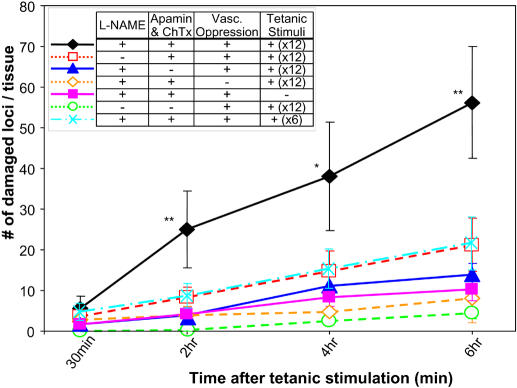
Severe ischemia induced by pharmacological interventions results in myofiber damage in control mouse receiving repeated tetanic stimulation.Numbers of damaged myofiber loci (y-axis) were counted throughout the entire tissue using in vivo microscopy and plotted against time after tetanic contraction (x-axis). For quantification of myofiber damage, the numbers of damaged sites (loci) were counted instead of numbers of the damaged fibers, because there are different types of damage observed along the length of a myofiber (see Methods for detail). When ischemia stress was provided by applying L-NAME, apamin plus charybdotoxin (ChTx), and vascular oppression, control mice showed progressive increase in the amount of muscle damage (closed diamond and black solid line) under the application of increased stimuli (12 times). However, when L-NAME (open square and red dotted line), apamin plus charybdotoxin (closed triangle and blue solid line), or vascular oppression (open diamond and orange dotted line) was lacking, a comparable amount of myofiber injury was not achieved. Even when all reagents were present, the amount of myofiber damage was minimal without tetanic contraction (closed square and pink solid line). Tetanic stimulation and vascular oppression alone did not cause significant myofiber destruction (open circle and green dotted line). Six times stimuli applied in control mice (X mark and blue dash-dotted line) did not induce an equivalent amount of myofiber damage as compared to 12 times control (black diamond) or to 6 times mdx mice (Figure 4, open black circle). N = 5 mice for each treatment. *:p<0.05, **:p<0.01, by ANOVA. Standard errors are shown as bars added to each point.